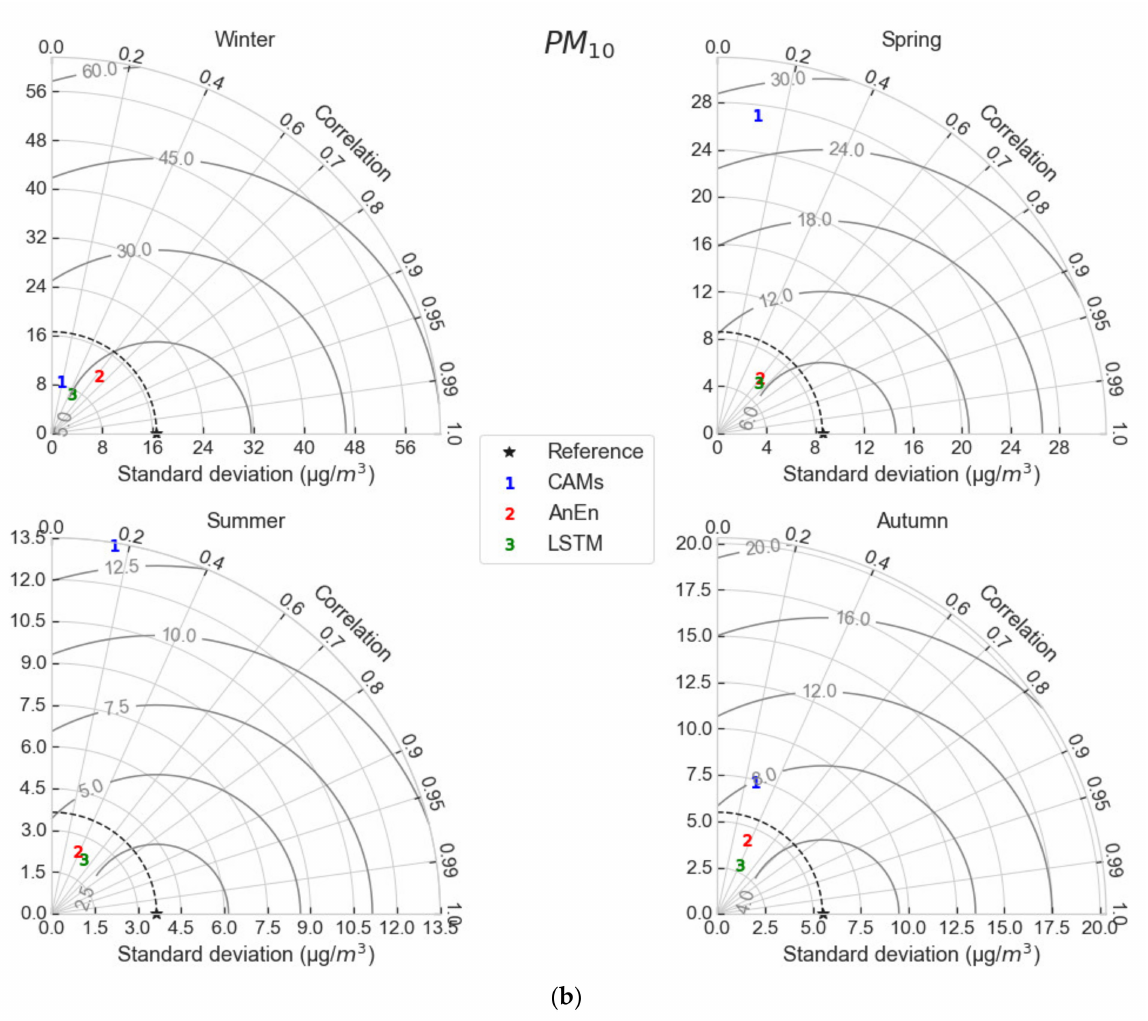
Figure 10. Composite skill of CAMS, AnEn and LSTM through seasonal Taylor plots ( a ) for PM2.5 and ( b ) for PM10 concentrations.